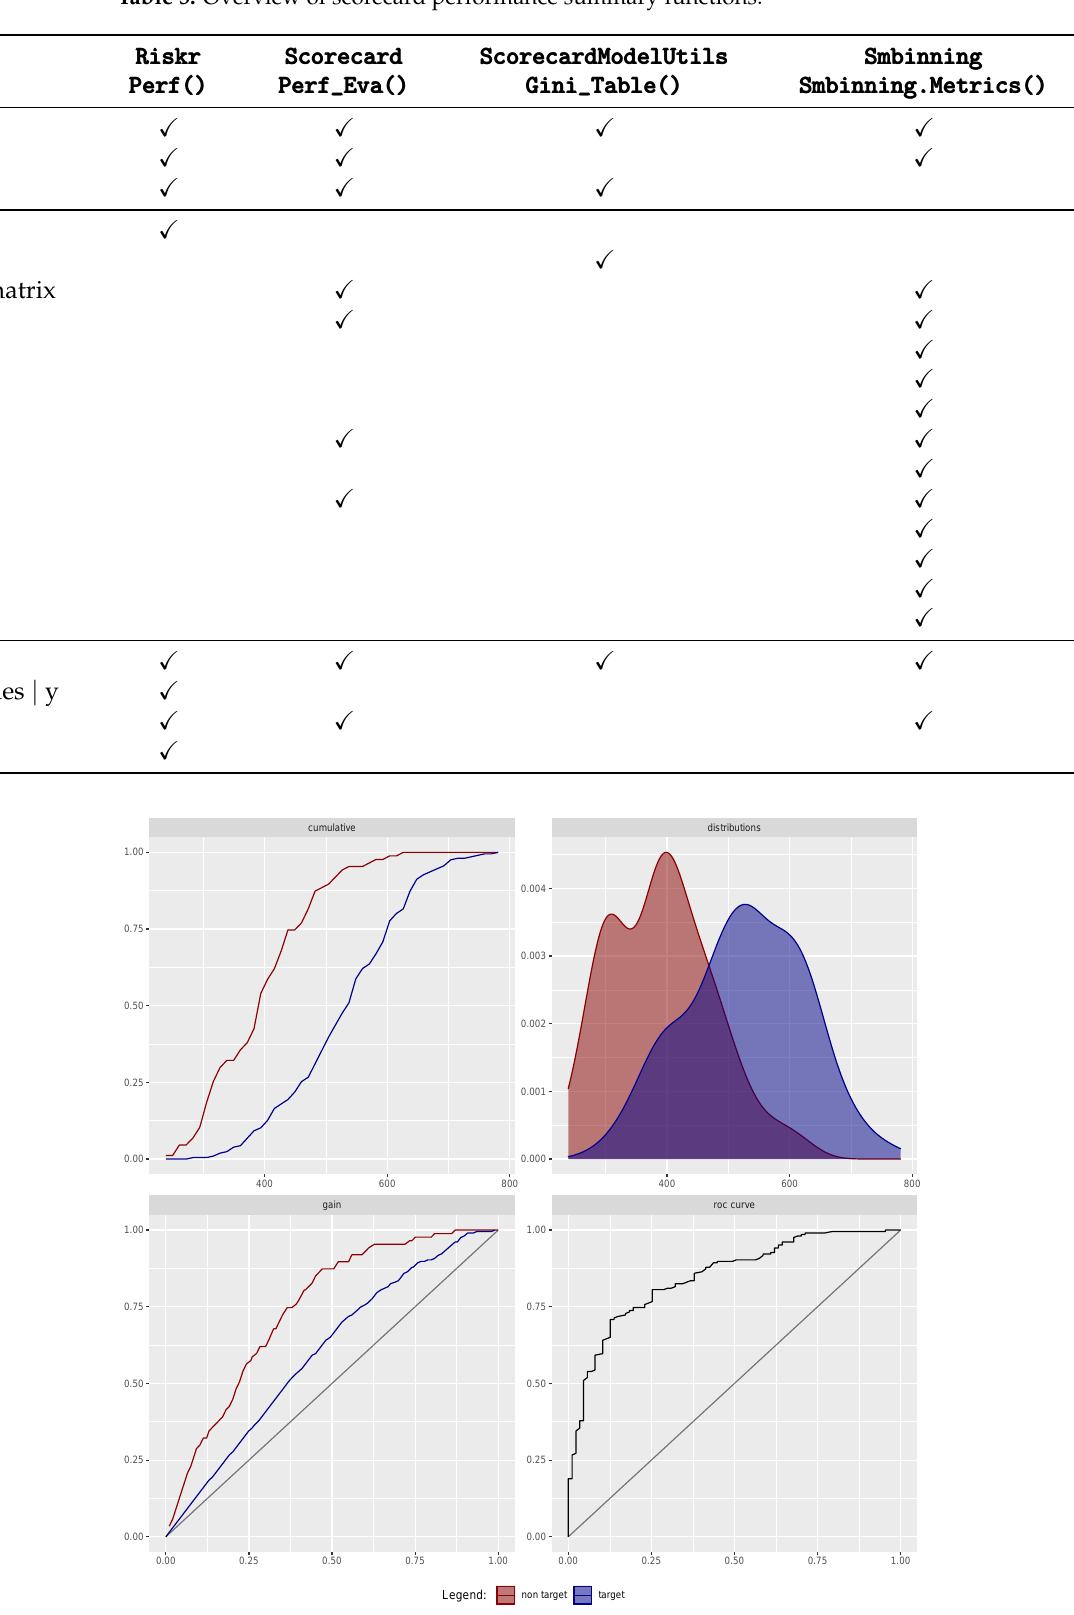
Figure 4. Scorecard performance graphs: ECDF ( top left ); score densities ( top right ); gains ( bottom left ); ROC ( bottom right